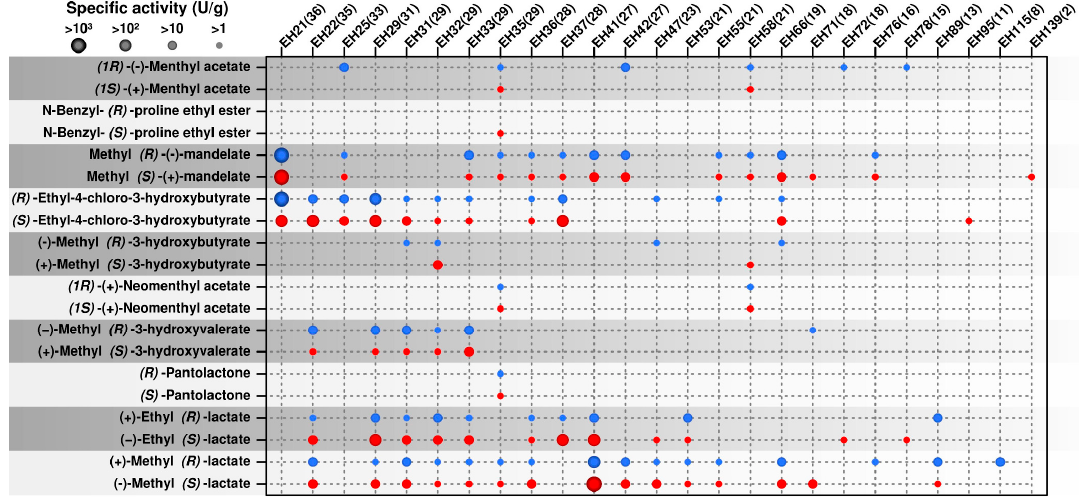
Figure 3. Chiral preferences of 25 hydrolases which were found to be selective for at least one chiral ester according to the 25-selective factor threshold. The figure illustrates the specific activity (U · g − 1 ; represented by the size of the circles) of each esterase per each of the 20 chiral esters tested. The ID code for each esterase (for full description see ref. [5]) is shown on the top; the number of esters (out of 96 tested) hydrolyzed by each esterase is shown in brackets. The Figure was created with the R language console from data previously reported [5]. The list of the 20 chiral esters tested is shown on the left, with ( R )-enantiomer in blue and ( S )-enantiomer in red color. The protocol established and used to identify the esters hydrolyzed by each esterase is described in Materials and Methods.